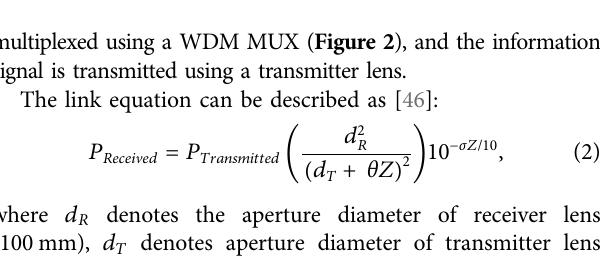
Frontiers in Physics |